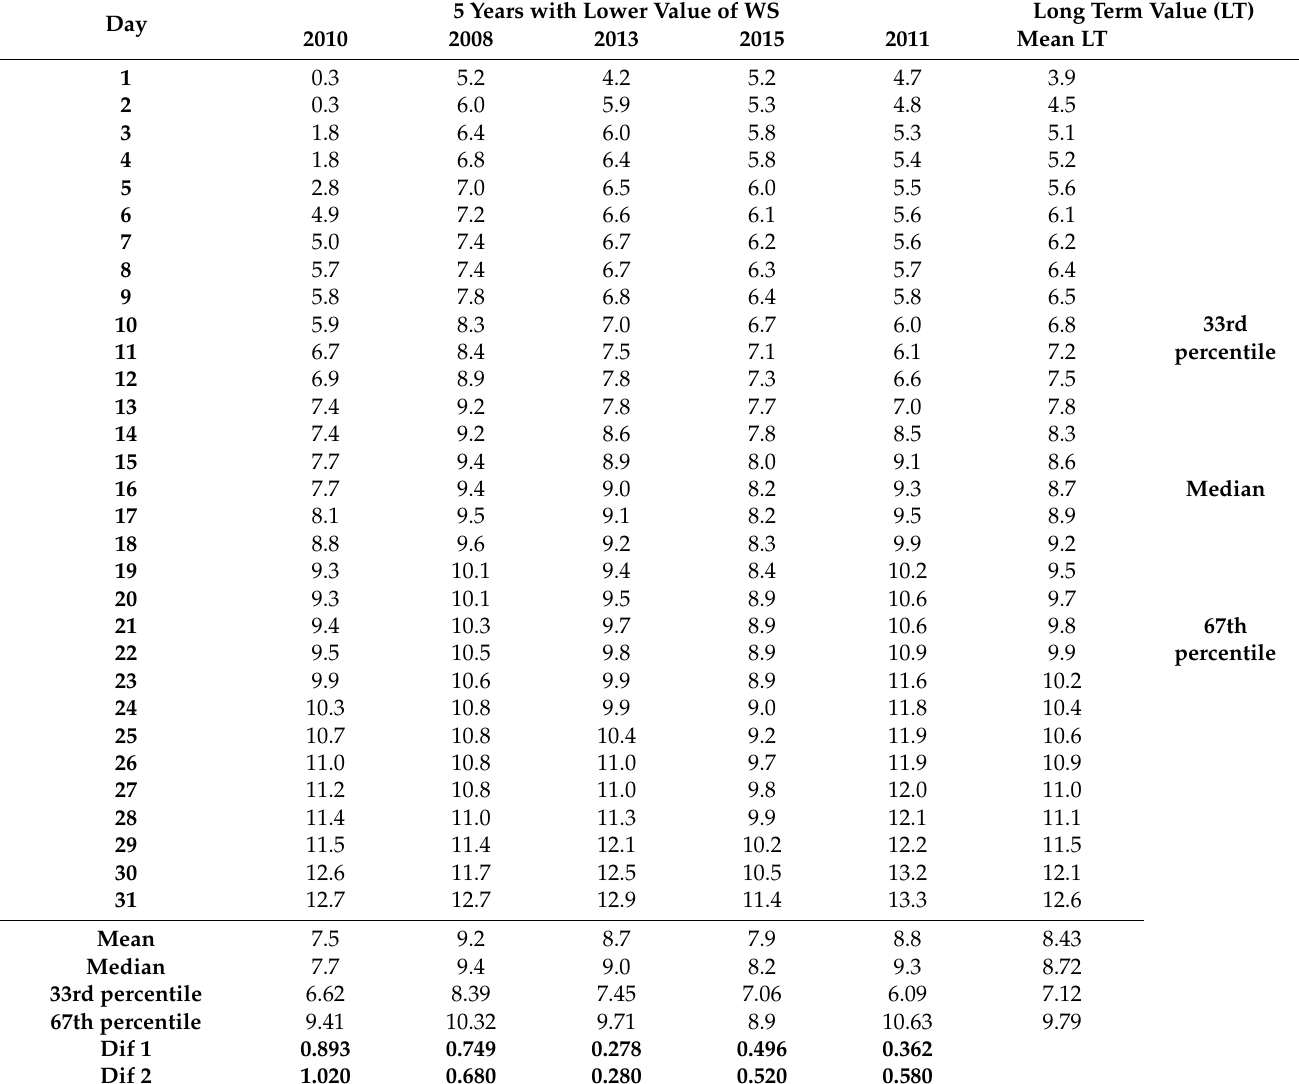
Table 6. Daily DTm temperature data for the month of January of the five selected years. 5 Years with Lower Value of Day